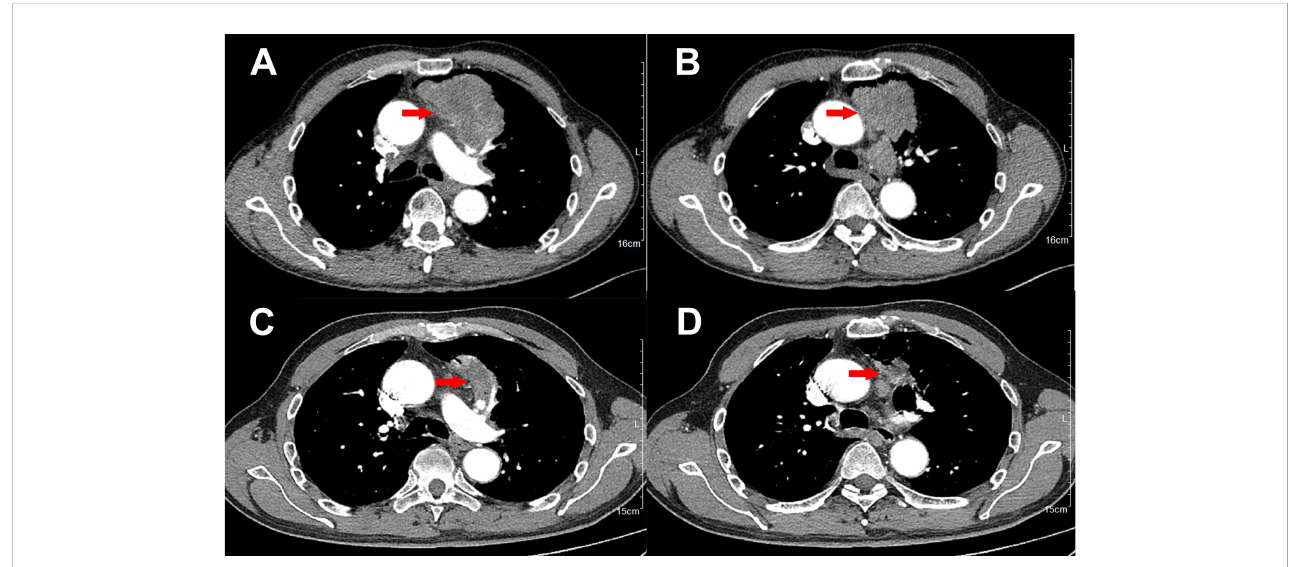
FIGURE 1 Variations of the primary lesions in lung by chest CT scans during the treatment (red arrowheads). (A, B) , June 6 th , 2022. (C, D) , August 27 th ,